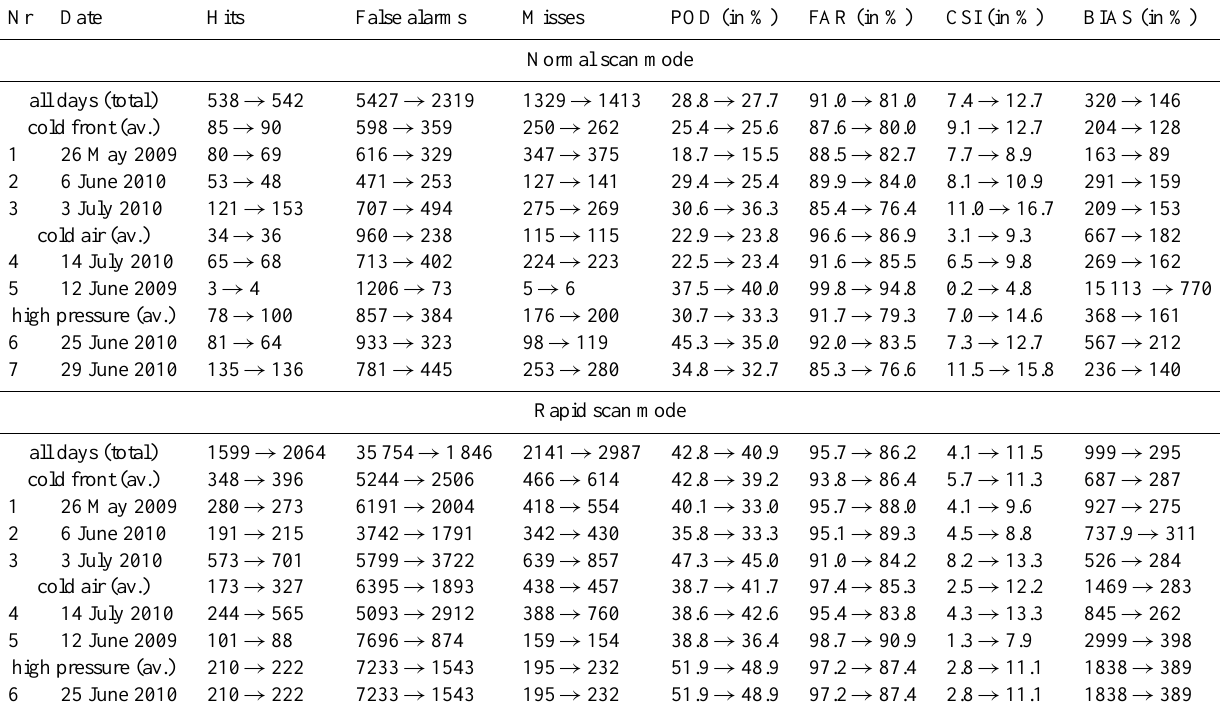
Table 4. Categorical variables and statistics under daytime (07:00–17:00UTC) conditions for the old and the new algorithm (old → new). Listed are the results for NS and RS mode for each of the test days as well as the results for the three synoptic classes. Hits, misses and false alarms are given as absolute numbers; POD, FAR, CSI and BIAS are expressed as a percentage. For each of the synoptic classes the average (av.) values are